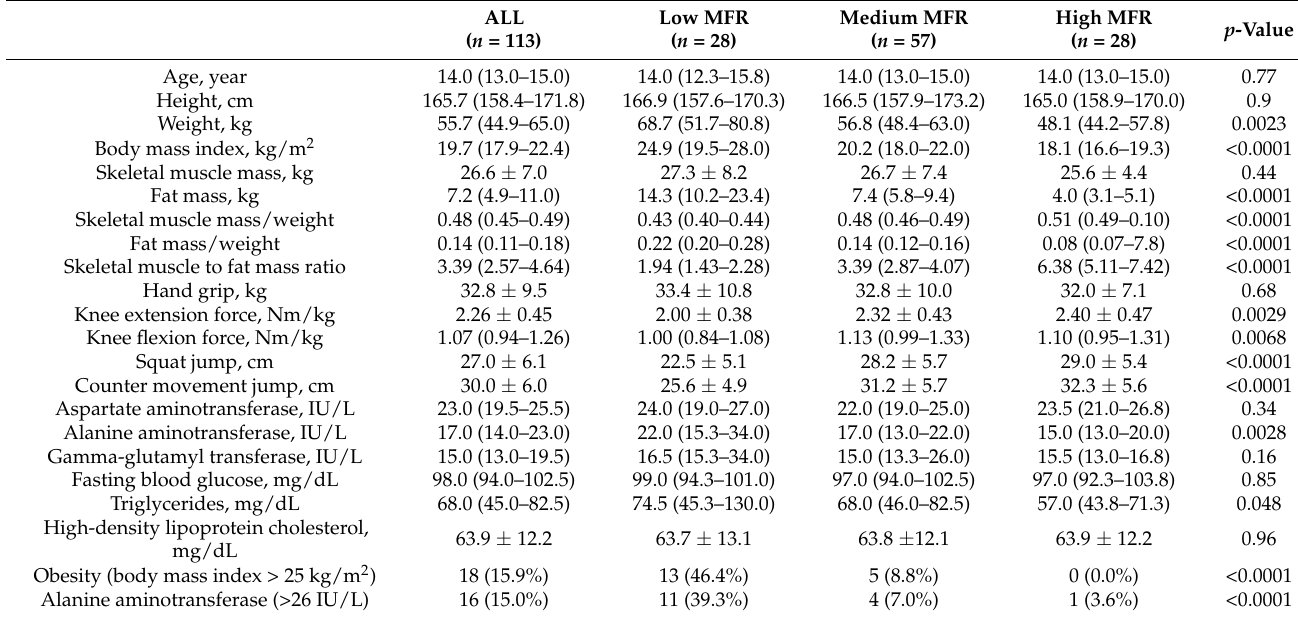
Table 1. Characteristics of study participants among the muscle-to-fat mass ratio tertiles.